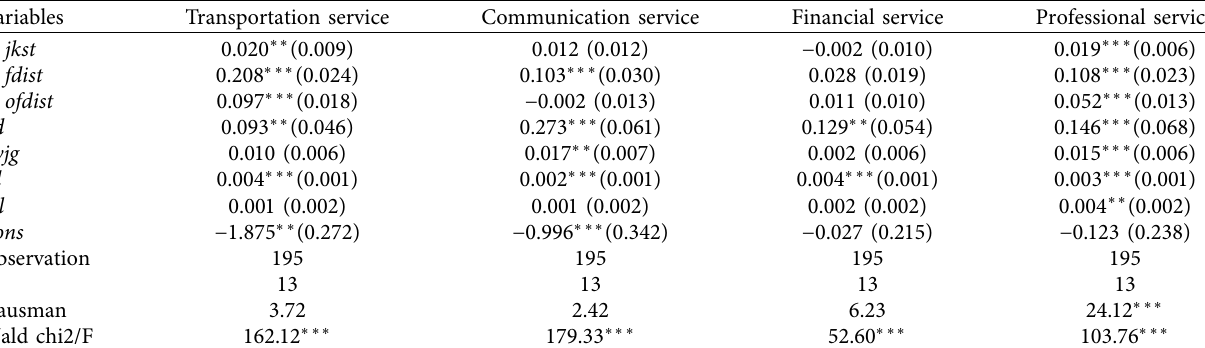
Table 4: Estimation results of producer service sector openness. Variables